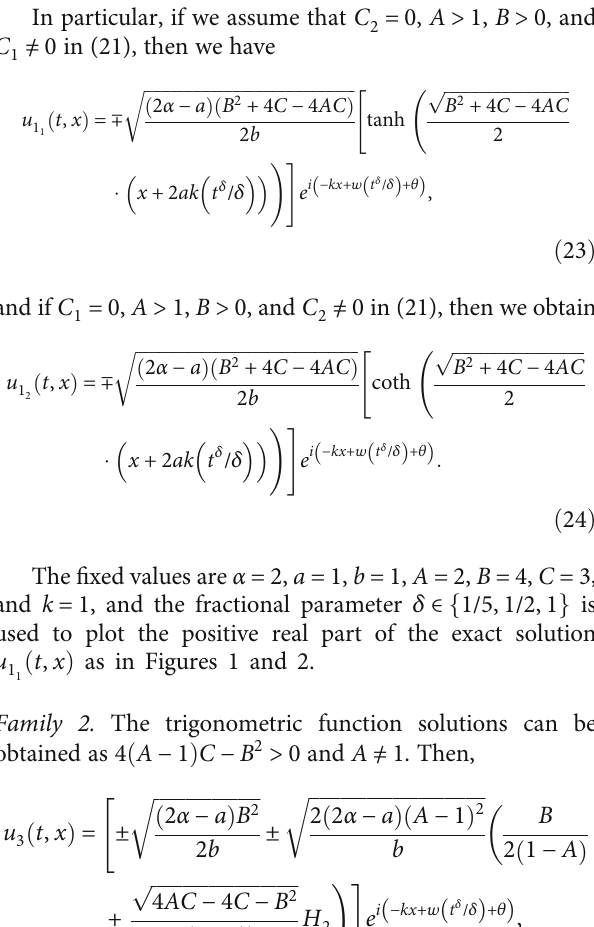
, x Þ at x = 1 : 0 in Equation 1 1 ð t